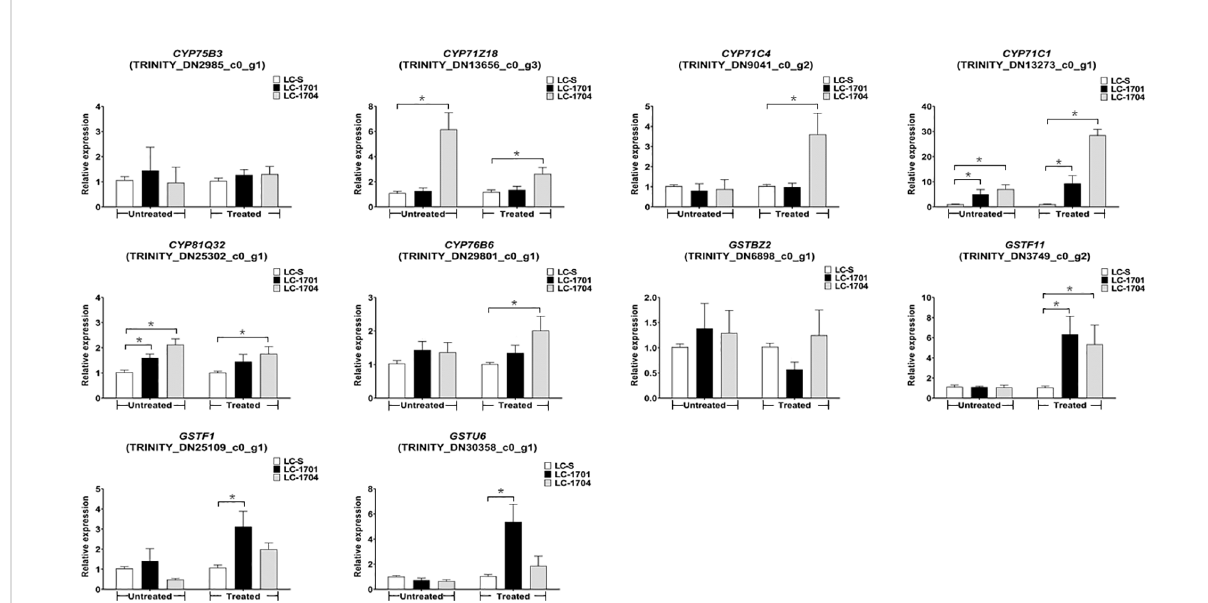
FIGURE 5 Relative mRNA expression levels of ten candidate genes in susceptible and resistant populations. The relative expression levels shown on the Y- axis were evaluated by the 2 - △△ Ct method. They represent the ratios of the normalized expression levels of the candidate genes in the resistant population to those of the same genes in the LC-S population. Results for the untreated and cyhalofop-butyl-treated plants grouped on the X- axis are separately analyzed. Error bars indicate the standard error of the mean for three independent replicates. Asterisks above the error bars indicate signi fi cant differences between the susceptible and the corresponding resistant populations in each group (one-way ANOVA followed by the LSD test; * P <